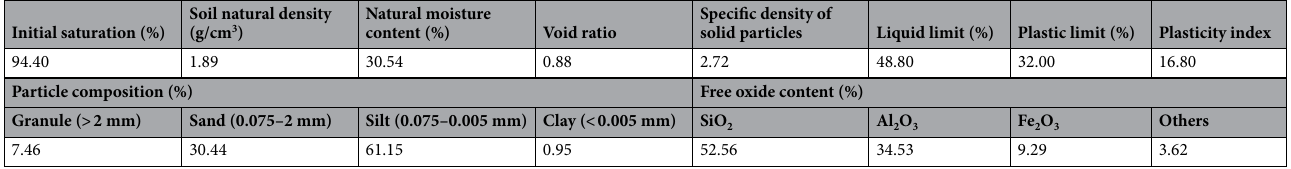
Table 1. Average values of physical properties and mineral composition.